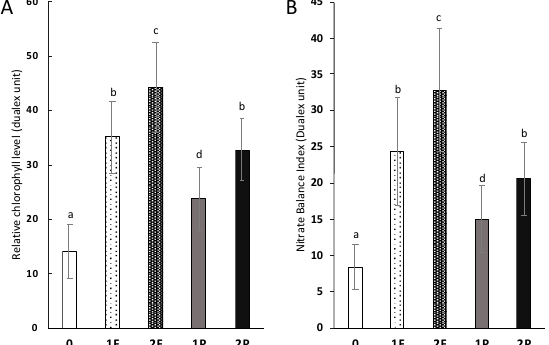
Figure 7. Impact of different field amendments on the pigment level of celery leaves. ( A ) Relative chlorophyll level (Dualex unit) and ( B ) nitrate balance index (Dualex unit) of the last third celery leaf. Unamended (0), one fertilizer application (1F), two fertilizer applications (2F), one procyanidin application (1P), and two procyanidin applications (2P). n = 30. Differences in letters (a, b, c and d) indicate a difference in treatment (Tukey’s test; α < 0.05).